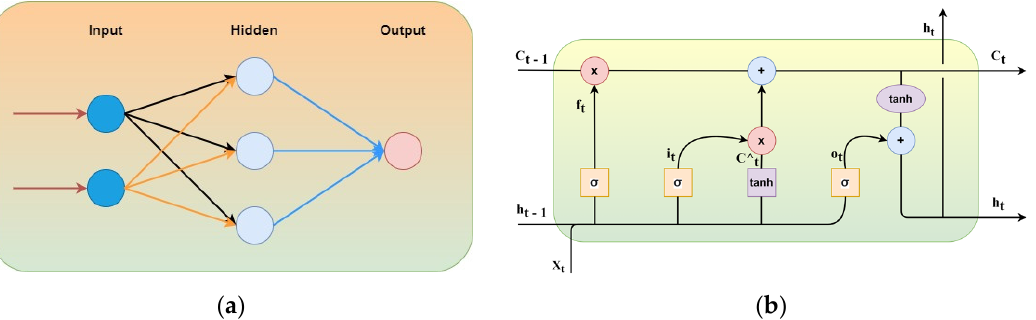
Figure 5. The basic architecture of ( a ) Normal ANN with two inputs and a single hidden layer; ( b )